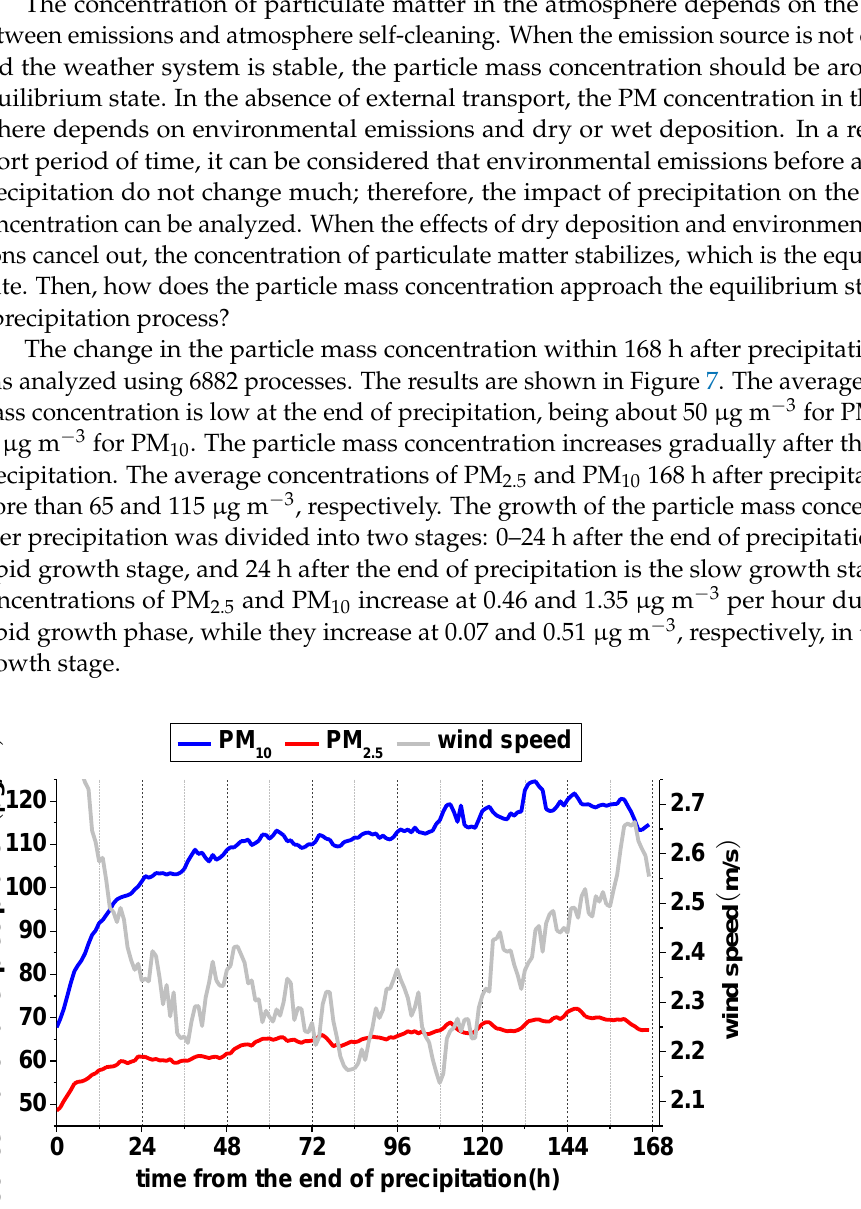
Figure 7. Changes in particle concentrations and wind speeds with time after precipitation ends. In this section, the reason for the growth rate of the particle mass concentration within 24 h after precipitation being greater than that after 24 h is